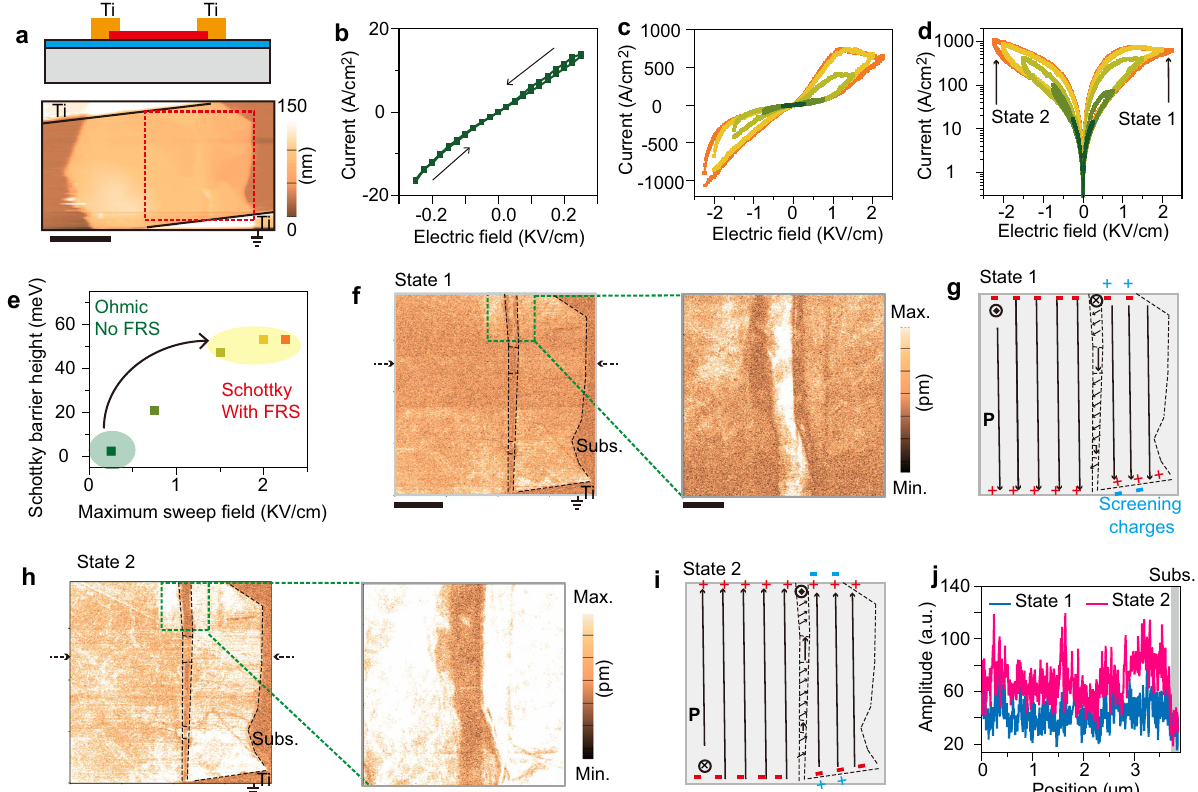
Fig. 2 A ferroelectric memristor (Dev. 1) with almost zero primary interface barriers and incomplete screening effect. a Schematic cross-sectional structure (top) and atomic force microscopy (AFM) image of Dev. 1 (bottom). Low-work-function titanium (Ti) was utilized to form Ohmic contact with α - In 2 Se 3 . Note that the bottom electrode was grounded. Scale bar: 2 μ m. b IV electrical curves of Dev.1 with electric fi eld sweeping below the α -In 2 Se 3 coercive fi eld, indicating a good Ohmic contact (i.e., nearly zero barriers). The arrows show sweeping directions. c Linear and d logarithmic plots of IV electrical curves sweeping back and forth under different maximum electric fi elds. Colors from orange to green represent 2.25, 2.00, 1.5, 0.75, and 0.25 KV/cm, respectively. e Estimated interface barrier height as a function of maximum sweep electric fi elds. The actual height is an average value collected from fi ve read biases (see Methods and Figure S3). f Piezoelectric force microscopy ( PFM) amplitude image for the channel marked by red dashed lines ( a ) under state 1. The right shows the enlarged PFM mapping of the area highlighted by blue dashed lines in the left panel. Scale bars: 1 μ m (left) and 0.2 μ m (right). g Illustration of ferroelectric domain con fi guration in f . and (cid:1) represent out-of-plane polarization orientations pointing inwards and outwards across this paper, respectively, whereas the arrows show in-plane polarization directions. h PFM amplitude mapping of state 2 channel and ( i ) its domain con fi guration illustration. Screening charges are highlighted by blue in g and i . j Comparison of piezo-response amplitudes taken from the lines marked by blue arrows in f and red arrows in h , respectively. Gray indicates background substrate